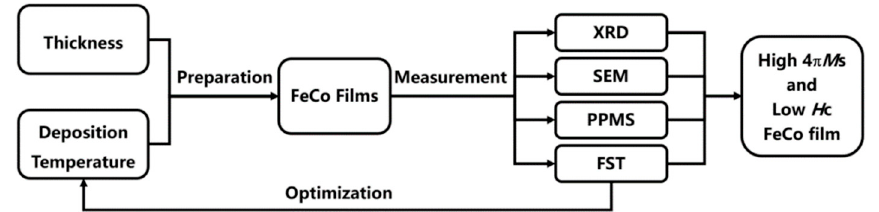
Figure 1. Flow chart for the preparation and testing of FeCo films.